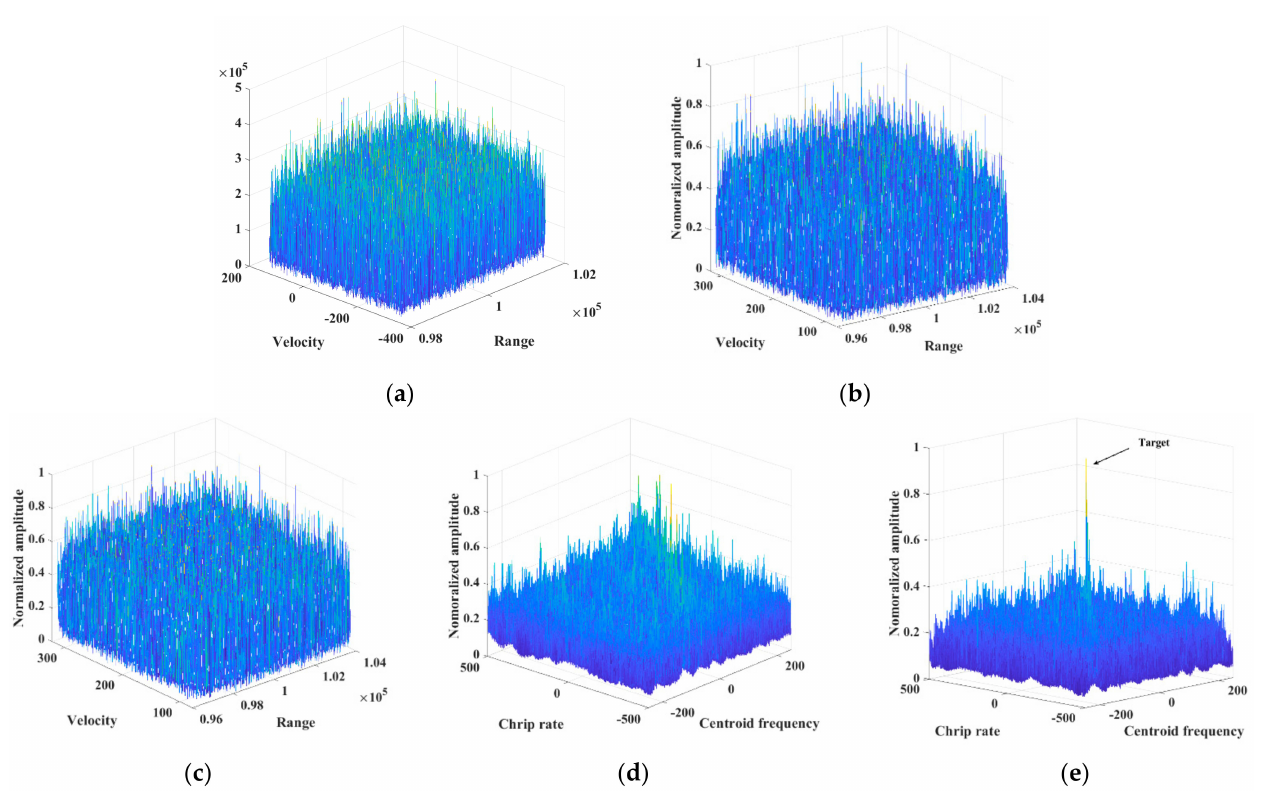
Figure 4. Coherent integration for a weak target via MTD, RFT, KTLVD, SKTRFT, and the proposed method: ( a ) MTD; ( b ) RFT; ( c ) KTLVD; ( d ) SKTRFT; ( e ) Proposed